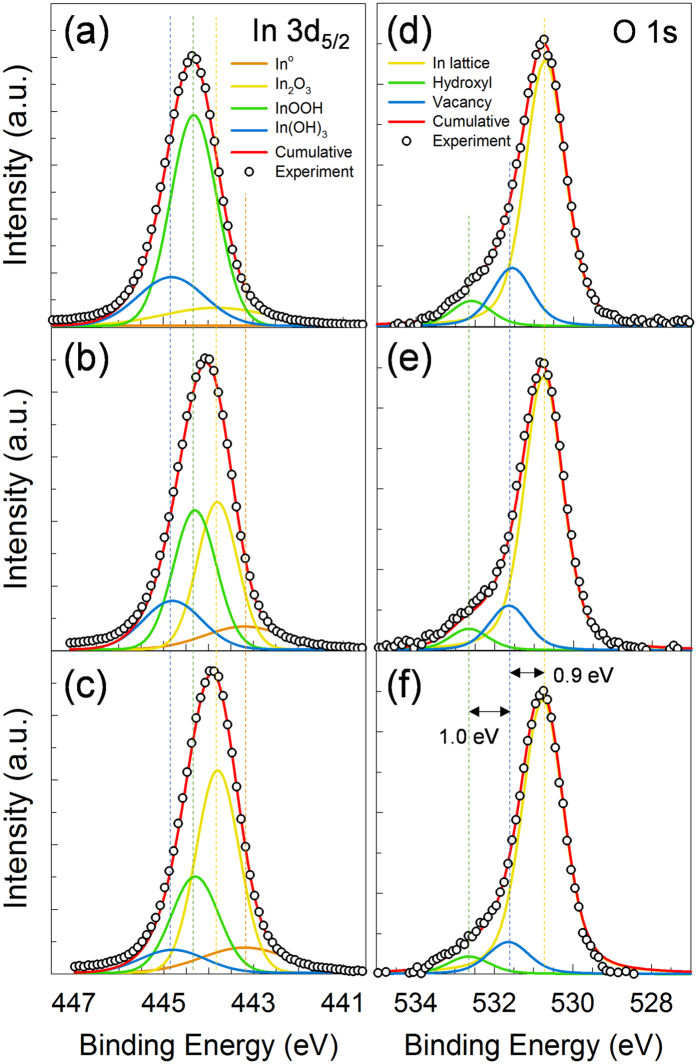
In 3d5/2 and O 1 s XPS spectra obtained for 250 °C-annealed In2O3 films with different Li+ loadings.(a–c) In 3d5/2 and (d–f) O 1 s, (a,d) 0, (b,e) 6.7 and (c,f) 13.5 mol%.